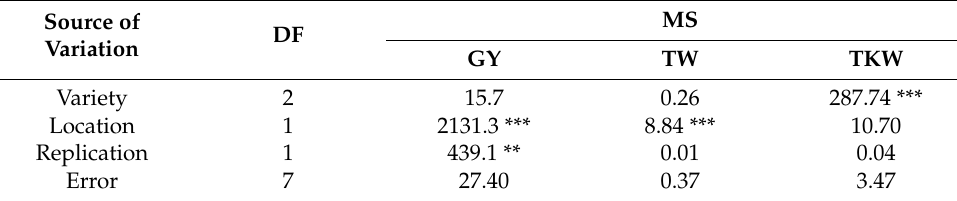
Table 1. Analysis of variance for grain yield and agronomical components.